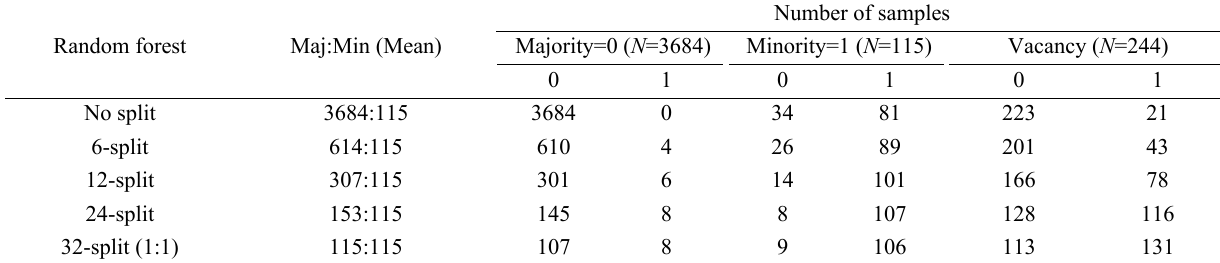
Table 8 Result from RF predictors using different splitting strategies (337 control variables). Random forest